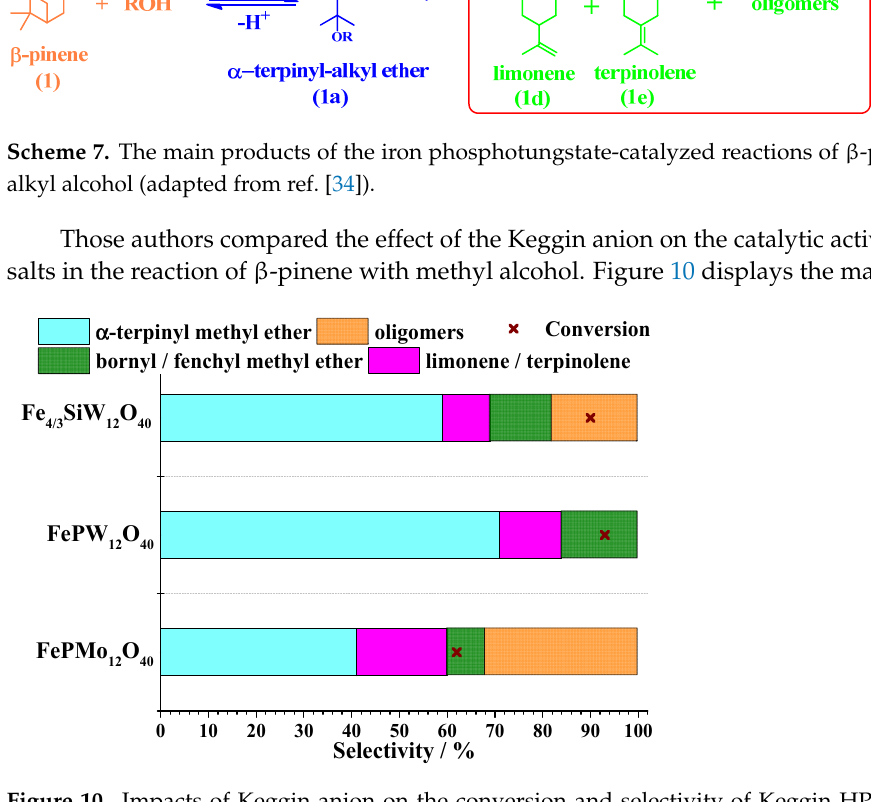
Figure 11. Impacts of metal cation on the conversion and selectivity of phosphotungstate-catalyzed reaction of β -pinene with methyl alcohol (adapted from ref. [34]) a . a Reaction conditions: β -pinene (3.8 mmol), CH 3 OH (14.3 mL), temperature (333 K), catalyst (0.50 mol%), volume (10 mL). The highest activity of the FePW 12 O 40 catalyst was a tt ributed to its highest Lewis acid- ity, which promotes the reaction of carbon skeletal of β -pinene and gives the α -terpinyl carbocation, the most probable reaction intermediate. The impact of the size of the carbon chain was also evaluated in reactions with C1- C4 alcohols and β -pinene (Scheme 8) [34].